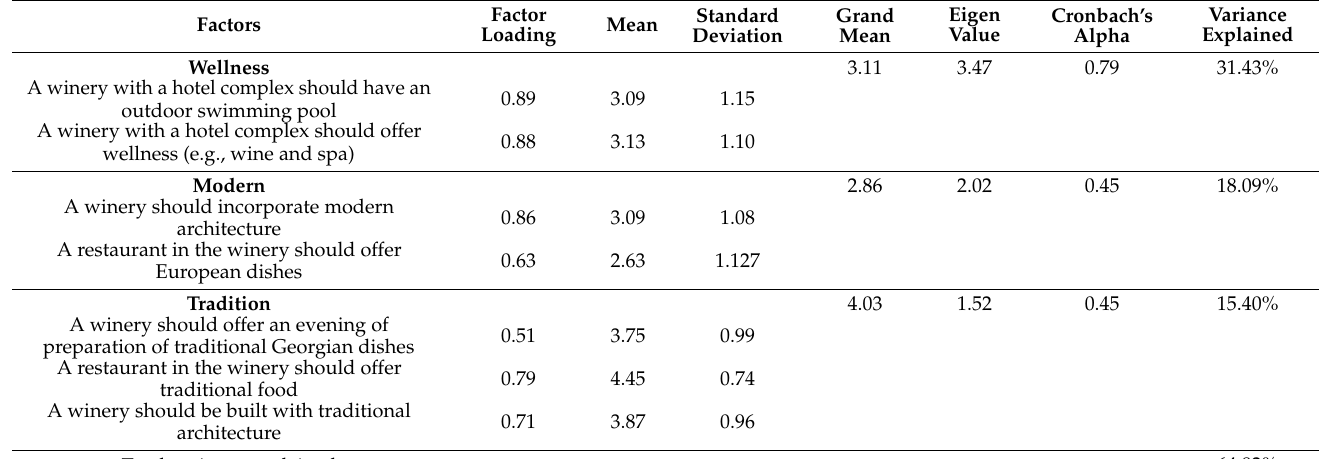
Table 5. Results of the factor analysis of expectations of experiences with respect to wineries in Georgia.